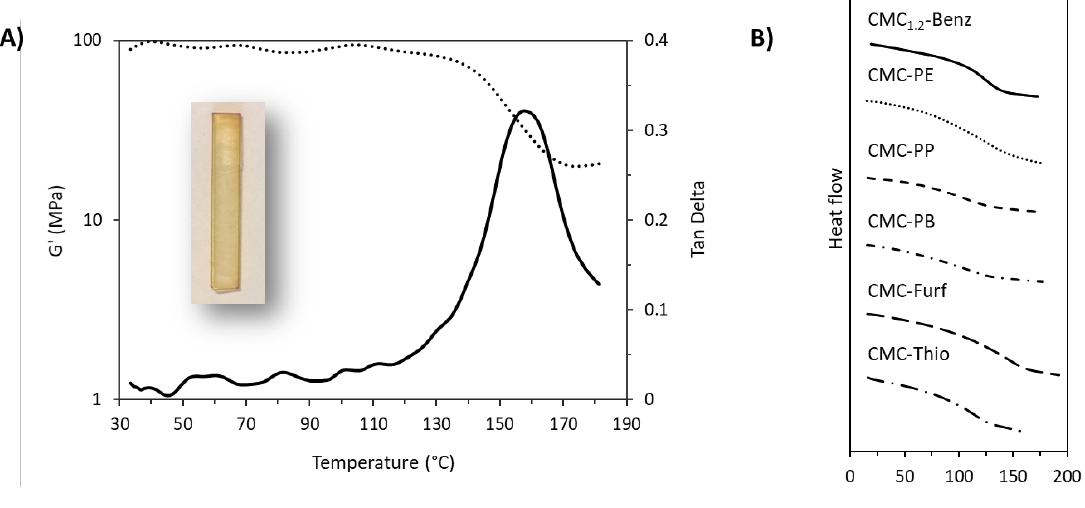
Figure 10. ( A ) Evolution of moduli G’ (- -) and of the loss tangent (tan δ ) (—) as a function of temperature for a film made from CMC 1.2 -Benz (Table 1, Entry 3); ( B ) DSC curves of CMC 1.2 -Benz (Table 1, Entry 3), CMC-PE (Table 1, Entry 6), CMC-PP (Table 1, Entry 7), CMC-PB (Table 1, Entry 8), CMC-Furf (Table 1, Entry 11), CMC-Thio (Table 1, Entry 12).